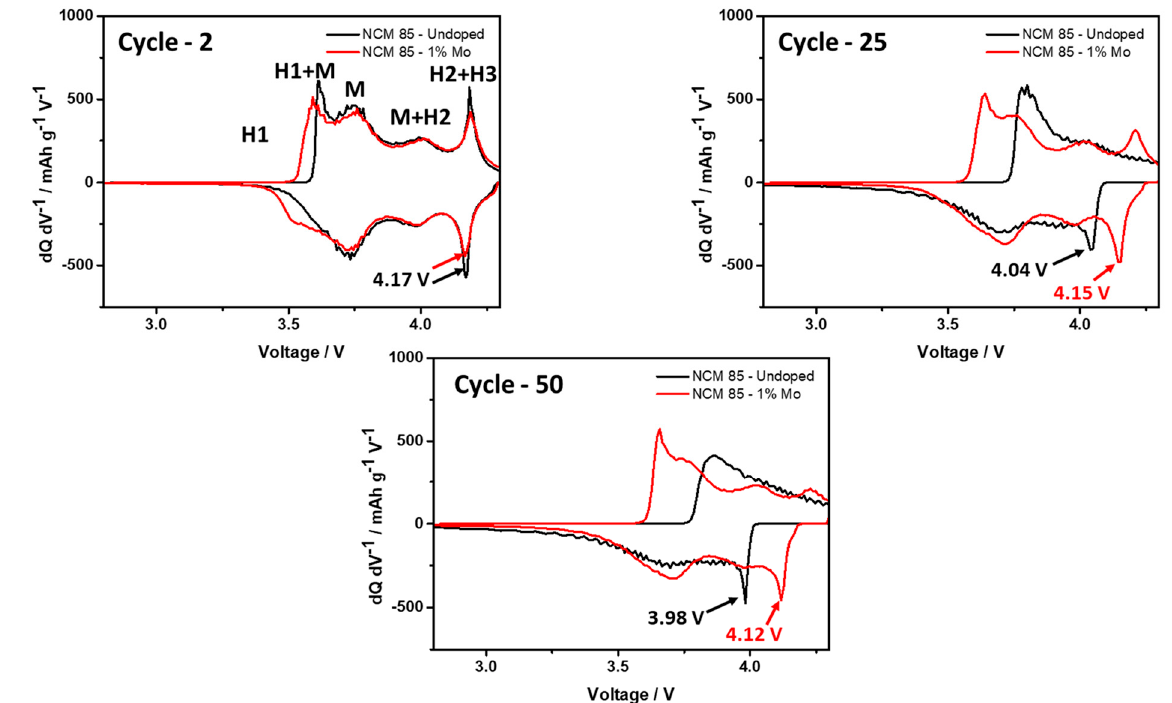
Figure 9. Differential capacity dQ/dV as a function of the cell voltage measured from electrodes comprising undoped and 1 at. % Mo-doped NCM85 materials, at 30 °C for cycles 2, 25, and 50.